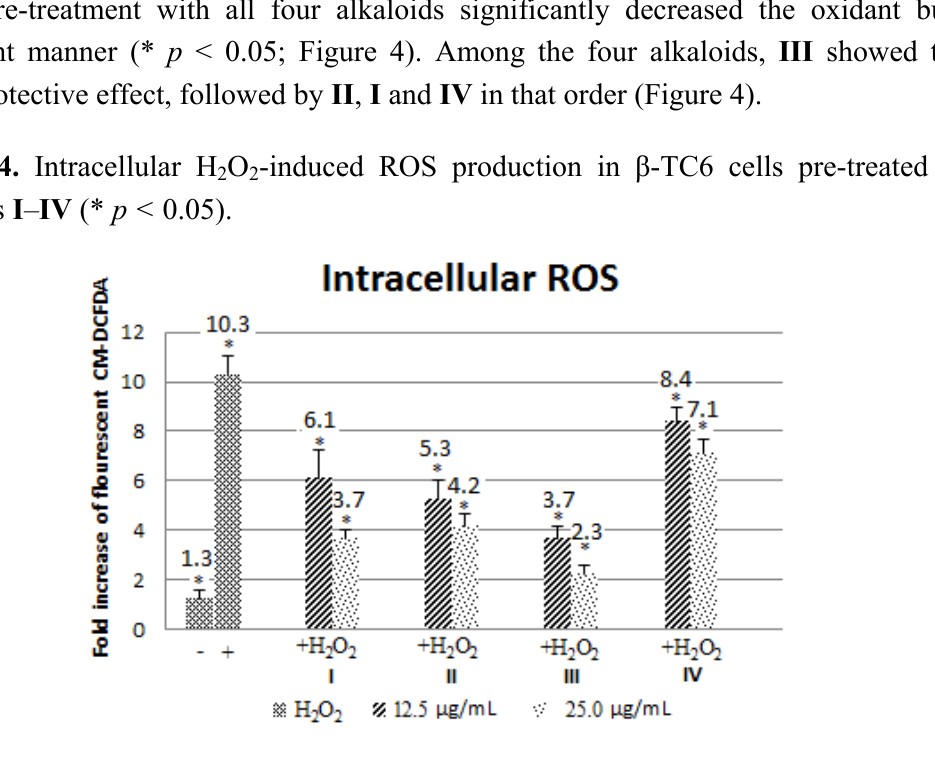
Figure 4. Intracellular H